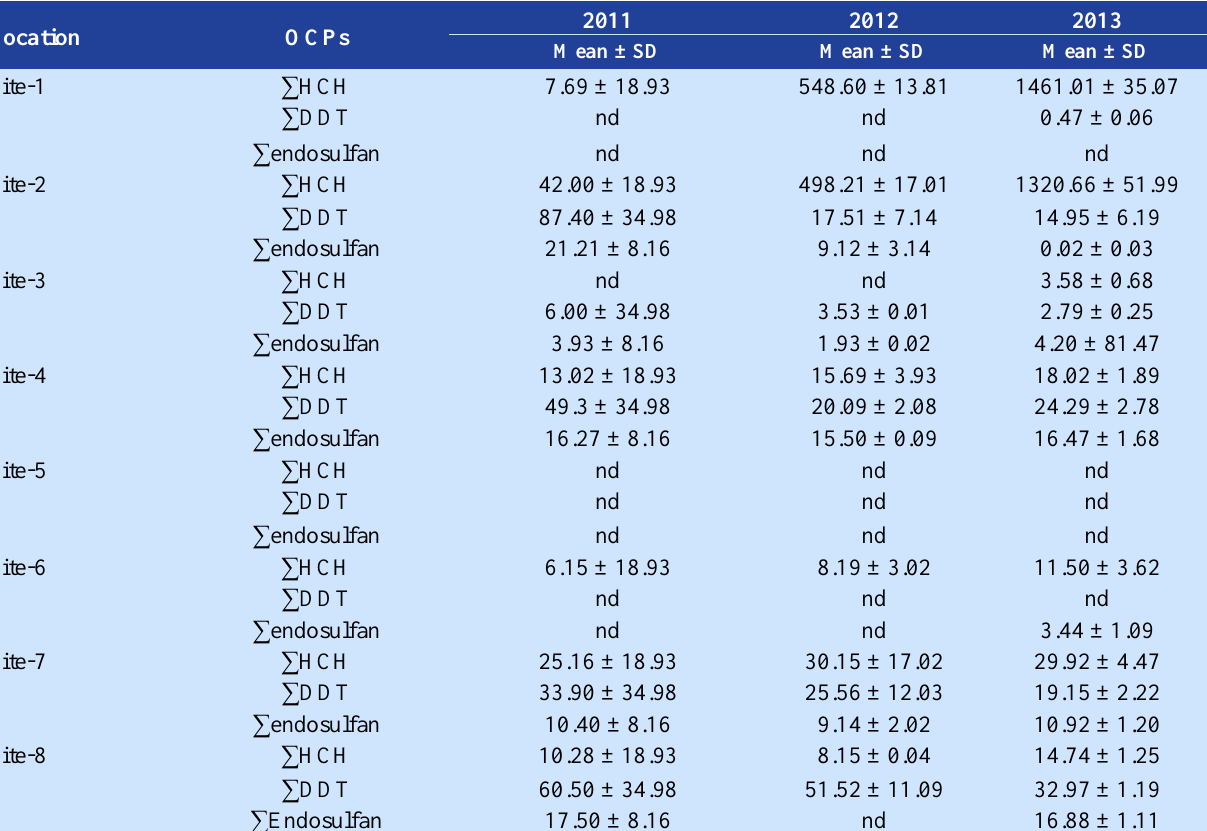
Table 3. Concentrations of organochlorine pesticides (OCP) in sediments (ng/g) of the Sabarmati River, Ahmedabad,